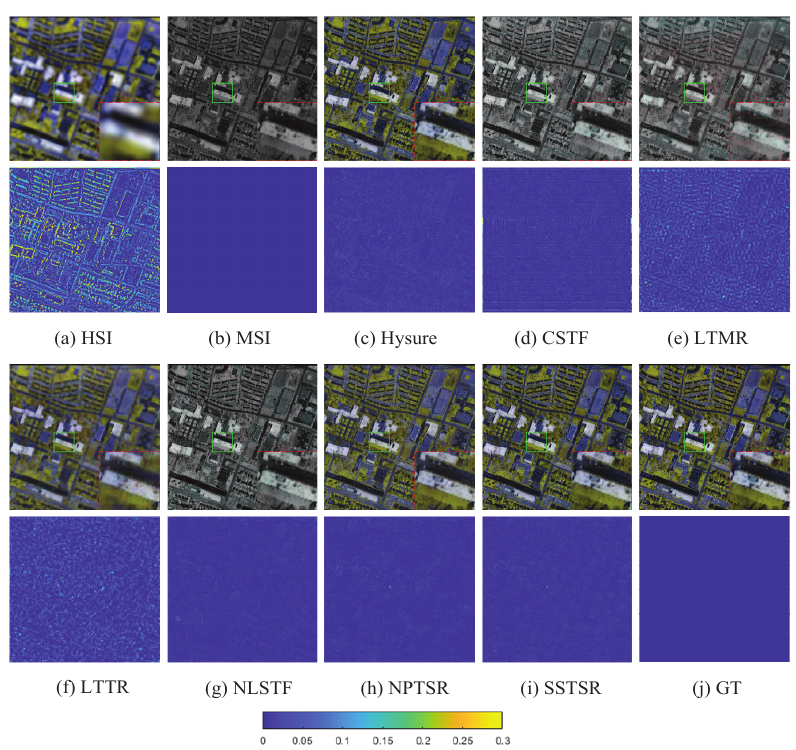
Figure 7. The first and third rows show the false color images (composited by bands 70, 45, 5) of the comparison methods on the Houston data set. The second and fourth rows show the normalized residual images of the comparison methods at band-50.